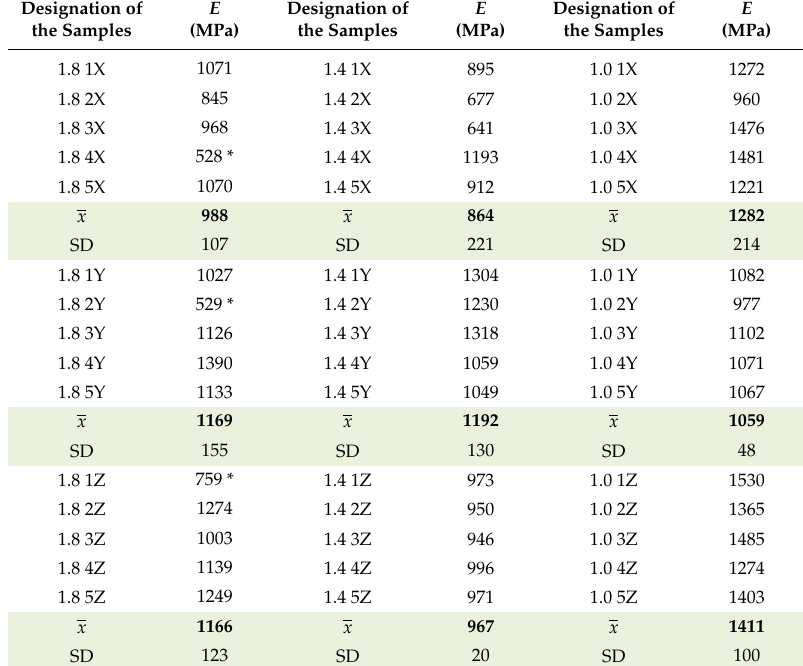
Table 4. Elastic modulus